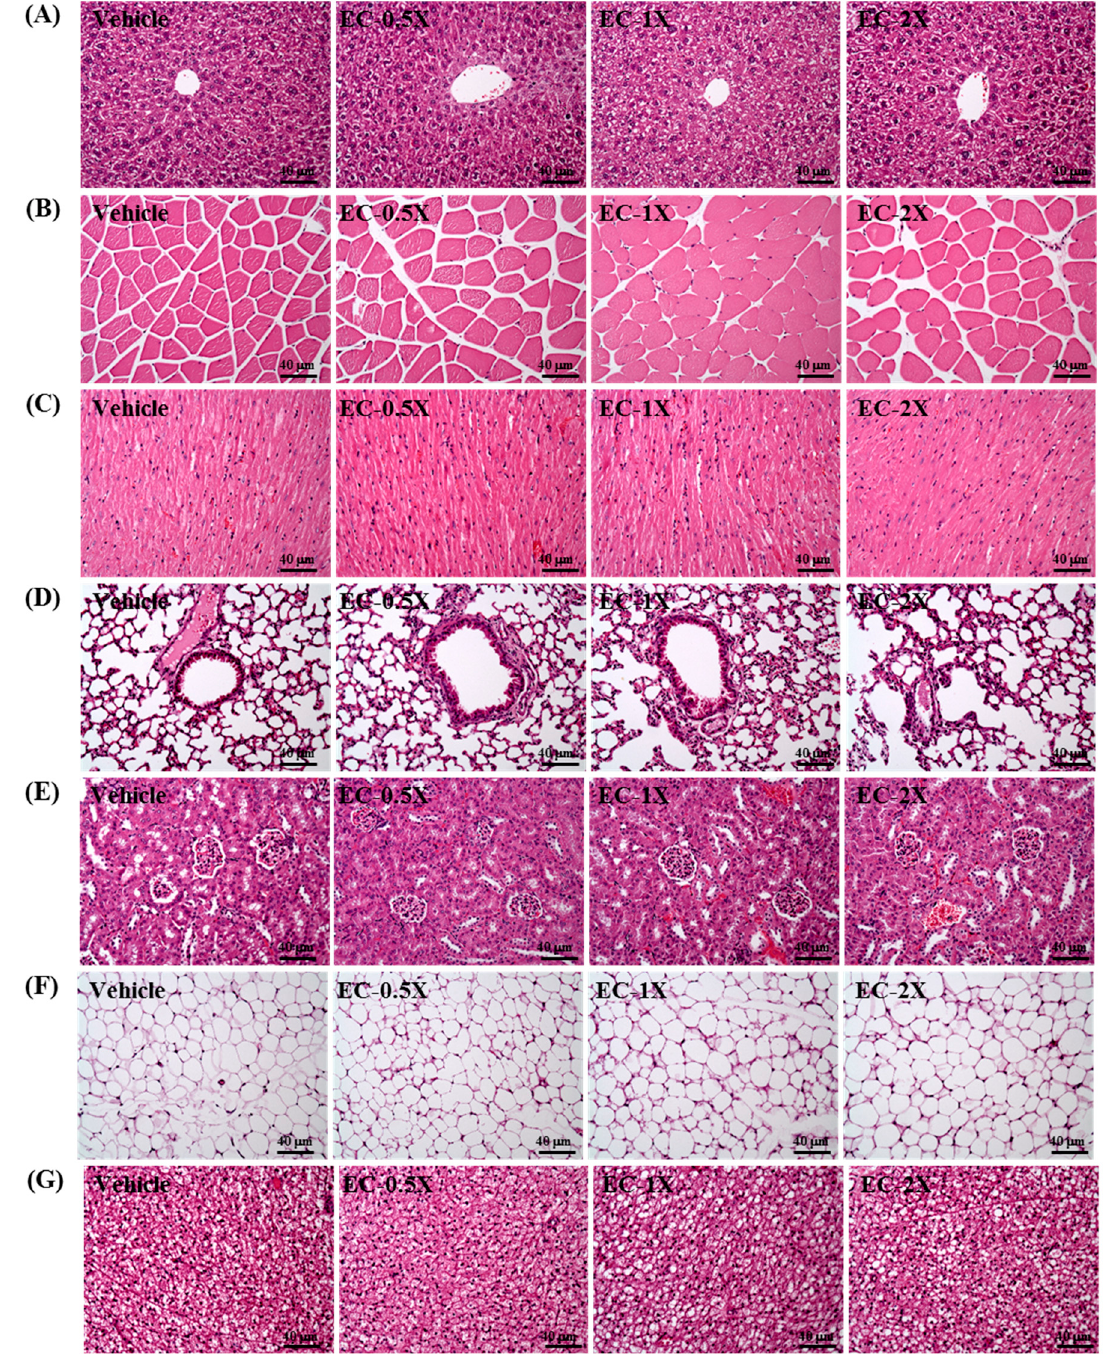
Figure 7. Effect of EC supplementation on histopathological evaluation of tissues, including (A) liver, (B) skeletal muscle, (C) heart, (D) lung, (E) kidney, (F) epididymal fat pad (EFP), and (G) brown adipose tissue (BAT). Mice were pretreated with the vehicle, EC-0.5X, EC-1X, and EC-2X for 28 days. Specimens were photographed with a light microscope (Olympus BX51). (Magnification: ×200, Scale bar, 40 µm).